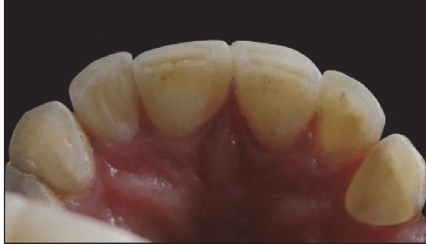
Figure 10: Occlusal view after diastema closure.